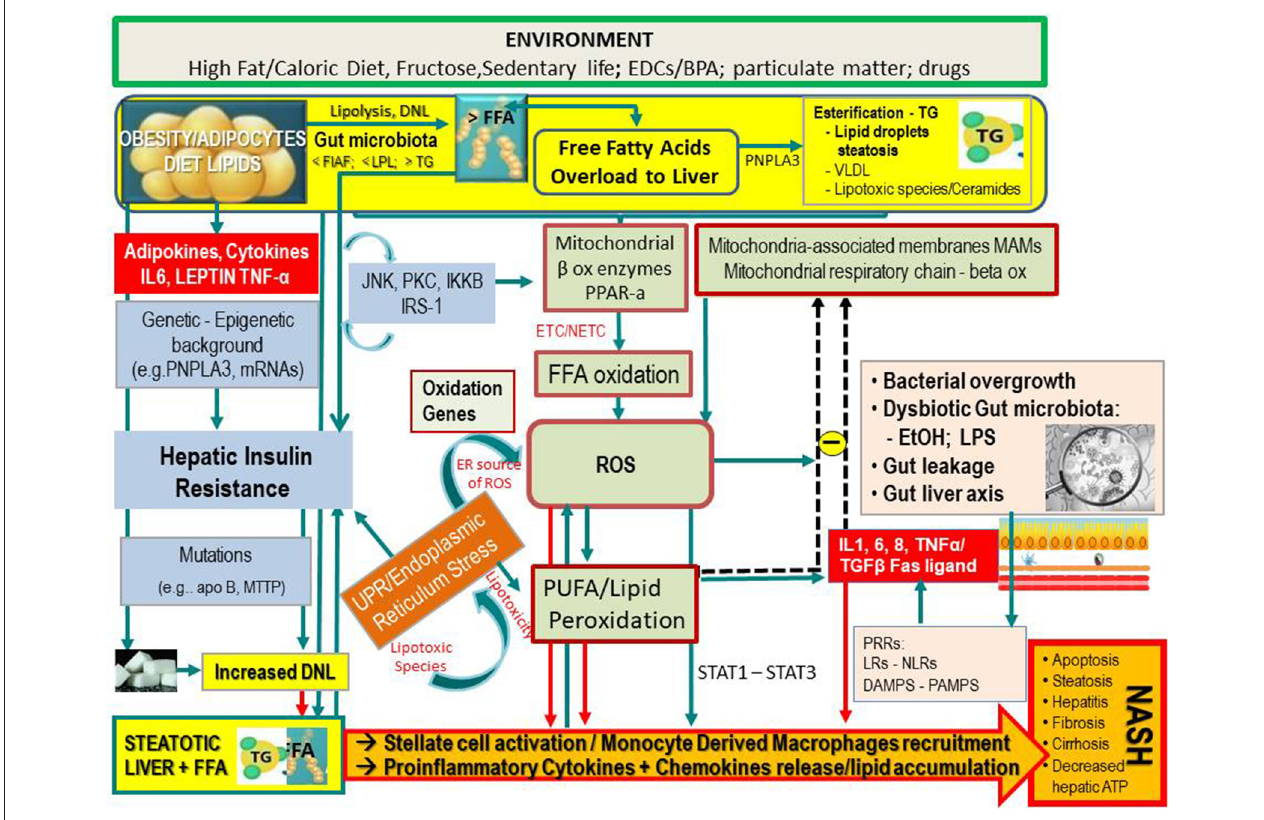
FIGURE 1 | Simplified flow of pathogenetic events in non-alcoholic fatty liver disease. The figure shows the crosstalk between systems and metabolisms in the pathogenetic events leading to fatty liver and its progression to NASH. In the upper part (yellow lane), one can note that hepatic FFAs derive from lipolysis in adipose tissue, dietary lipids, and DNL from COH in the liver. These FFAs may either be stored in the liver as TG droplets (hepatic steatosis) or be exported as VLDL to adipose tissue. FFA overload may concur in the hepatic IR (vertical light azur lane), which interplays with the JNK, PKC system where the activation of JNK1 may impair insulin signaling via serine phosphorylation of IRS1. The UPR/ER stress is a source of ROS and of lipotoxic species and plays a link between the OX stress and IR. Upon disruption of mitochondria-associated membranes (MAM) integrity, miscommunication directly or indirectly disrupts Ca 2 + homeostasis and increases ERS (brown box) and OS, leading to defective insulin secretion and accelerated lipid droplet formation in hepatocytes. Inflammatory mediators (adipokines, cytokines) in large part arrange the progression from NAFLD to NASH (red boxes) in case of shortage of endogenous antioxidant molecules. These mediators are variously triggered by oxidative hepatic environment [ROS, lipid peroxidation] and bacterial overgrowth (pink boxes) after the infraction of the gut barrier (gut leakage) by bacterial Eth and enhanced intestinal permeability, which allows lipopolysaccharides (a) to activate PRR–LRs—NLRs–DAMPS—PAMPS and (b) to concur with ROS/PUFA in the inhibition of the mitochondrial respiratory chain. Lipotoxic lipid species lead to hepatic stress and subsequent release of extracellular vesicles, cytokines, chemokines, and DAMPs from hepatocytes. This results in enrolment of bone marrow immune cells. As shown in the lower part of the figure, liver-resident stellate/KCs are activated by several triggers (mainly ROS, gut microbiota), resulting in the release of chemokine (C-C motif) ligand 2 (CCL2) and other proinflammatory cytokines (i.e., TNF- α , IL-1, and IL-6). The oxidative hepatic environment also stimulates transcription programs (STAT-1 and STAT-3) promoting T-cell recruitment and hepatic disease progression. Overall, the scenario ultimately leads to the recruitment of bone marrow–derived monocytes and neutrophils that further contribute to the inflammatory response and a rebound ROS production. A number of genetic variants are implicated in NAFLD development, and progression is shown. BPA, bisphenol A; CYP, cytochrome; COH, carbohydrates; DAMPS, damage-associated molecular patterns; DNL, de novo lipogenesis; EDC, endocrine-disrupting chemicals; ETC, electron transport chain; Eth, ethanol; FFA, free fatty acids; FIAF, fasting-induced adipose factor; HNE, hydroxynonenal; IKKB, inhibitor of nuclear factor κ B kinase subunit β ; IL, interleukin; IRS, insulin receptor substrate; JNK, c-Jun N-terminal kinase; LPL, lipoprotein lipase; LPS, lipopolysaccharide; LRs, lectin receptors; MAM, mitochondria-associated membrane; MDA, malondialdehyde; mRNA, microRNA; MTTP, microsomal triglyceride transfer protein; NAFLD, non-alcoholic fatty liver disease; NASH, non-alcoholic steatohepatitis; NLRs, NOD-like receptors; NF- κ B, nuclear factor κ -light-chain enhancer of activated B cells; NTC non-electron transport chain; PAMPs, pathogen-associated molecular patterns; PKC, protein kinase; PNPLA3, patatin-like phospholipase domain-containing protein 3; PRR, pattern recognition receptor; PPAR, peroxisome proliferator-activated receptor; PUFA, polyunsaturated fatty acids; ROS, reactive oxygen species; TG, triglyceride; TNF, tumor necrosis factor; UPR, unfolded protein response; VLDL, very low-density lipoprotein; < , decrease; > , increase.